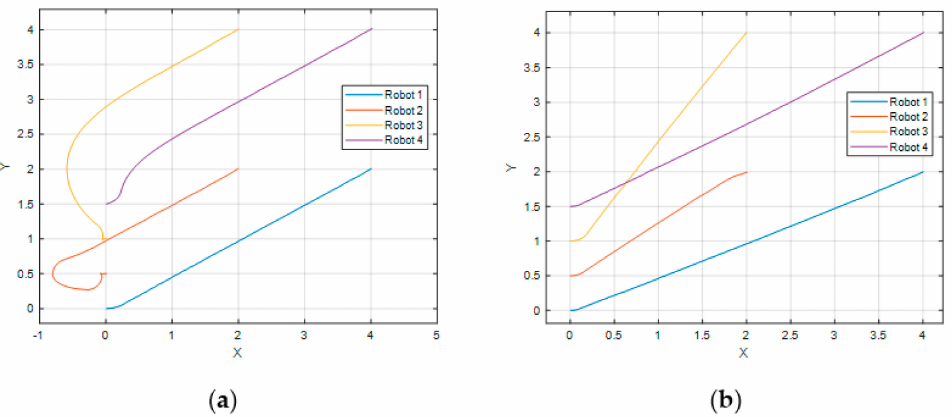
Figure 22. Movement of the robots in the plane in the comparison tests without collision avoidance: ( a ) Scheme proposed in this research; ( b ) scheme proposed in [21].